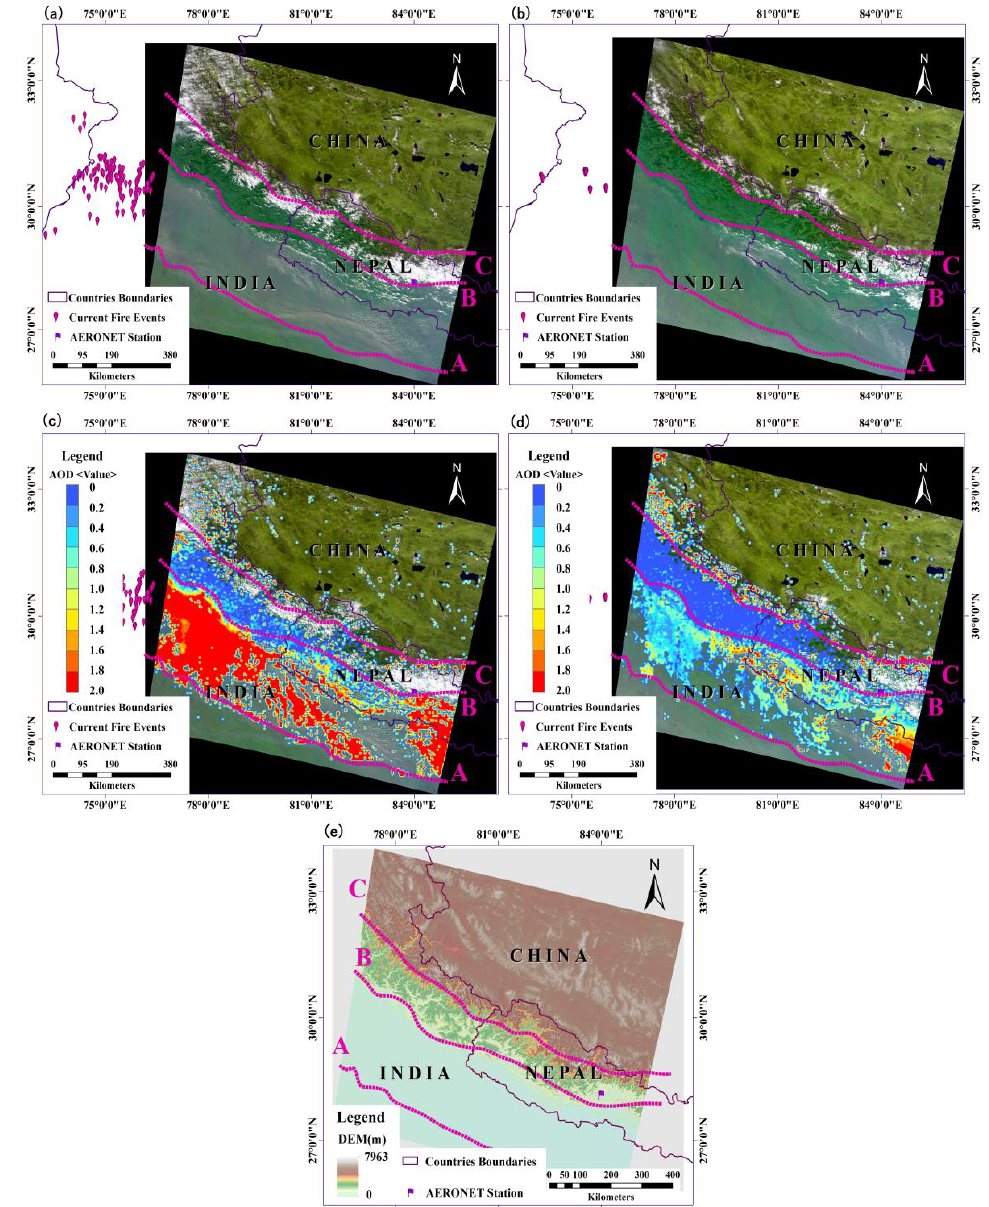
Figure 7. Examples of the AOD retrieval over South Asian region: ( a ) RGB image from TANSO-CAI on 4 November 2011; ( b ) RGB image from TANSO-CAI on 7 November 2011; ( c ) retrieved AOD at 550 nm on 4 November 2011; ( d ) retrieved AOD at 550 nm on 7 November 2011; and ( e ) topographic image.